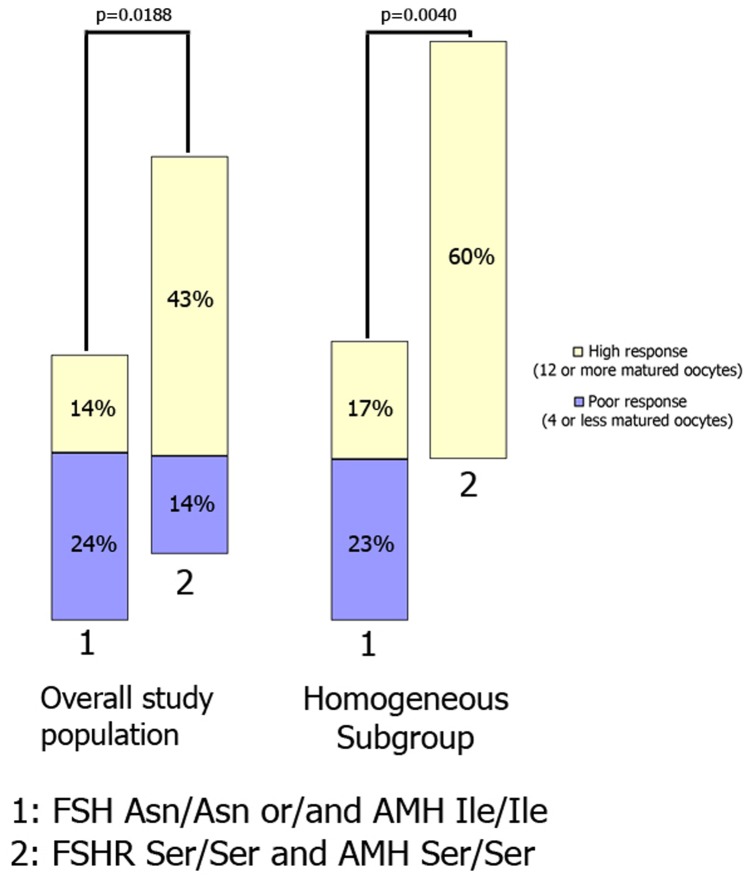
Poor and high response risks, according to FSHR680 and AMH49 polymorphism genotypes.